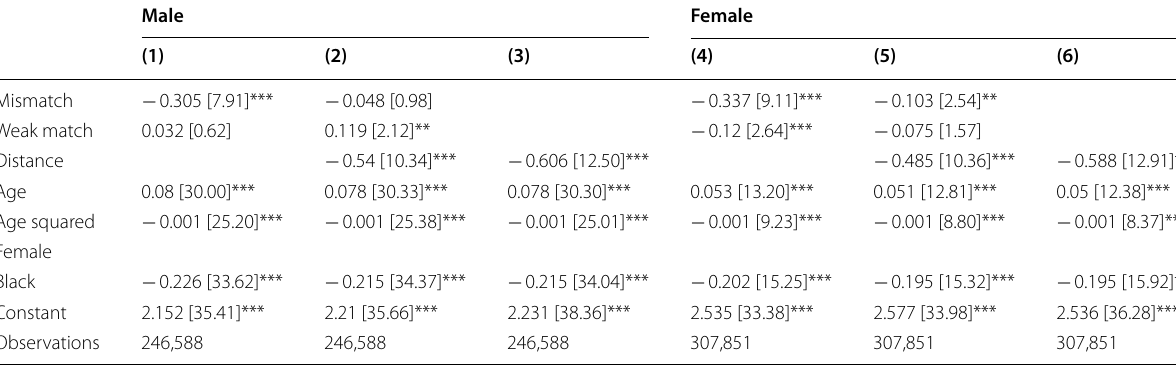
The dependent variable is the logarithm of the hourly labor earnings. All regressions include regional dummies and dummies for fields of study. Regressions are estimated by OLS and robust t-Statistics are in brackets Standard errors are clustered at the occupation-field of study level *, **, ***—indicate significance on the 10%, 5% and 1% level